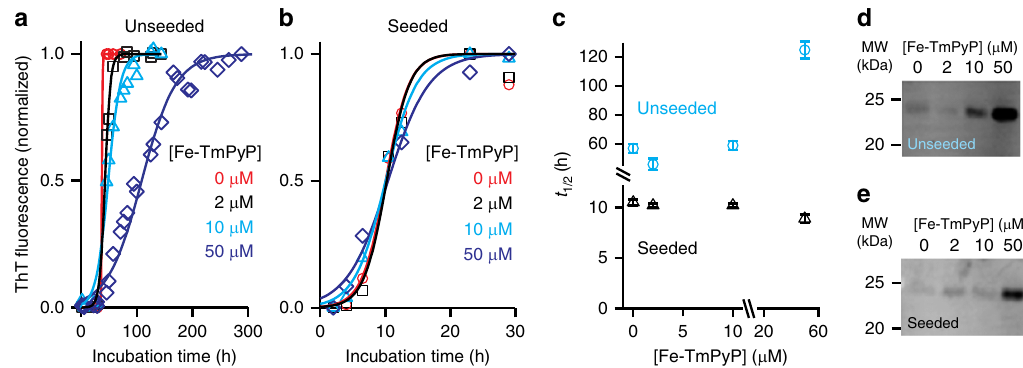
Figure 5 | Effect of Fe-TMPyP on ensemble aggregation kinetics. ( a ) Time course of aggregation monitored by ThT fluorescence measured at different concentrations of Fe-TMPyP, without seeds present. Solid lines: fits to equation 5. ( b ) Same in the presence of seeds. ( c ) The time to reach half-maximal fluorescence was unaffected by Fe-TMPyP dose with seeds present, but was increased by a high dose in unseeded reactions. ( d , e ) The amount of soluble PrP not sequestered in fibrils increased significantly at high Fe-TMPyP doses for both ( d ) unseeded and ( e )